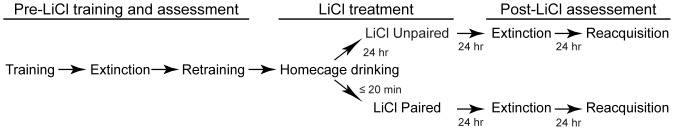
Overview of experimental phases and design.
Pre-LiCl training and assessment: Initial training (detailed in Table 1) was followed by one (limited training) or more (extended training) cycles of extinction and retraining. Data from the last extinction and retraining sessions were used for pre-LiCl measures. LiCl treatment: The day after the last retraining session, all animals received the appropriate drinking solution in their home cage. LiCl injections were given either at the end of the home cage drinking period (paired treatment condition), or given 24 hours later (unpaired treatment condition). Post-LiCl assessment: The test for habitual behavior occurred 24 hours after LiCl injection, and was followed 24 hours later by the reacquisition test.